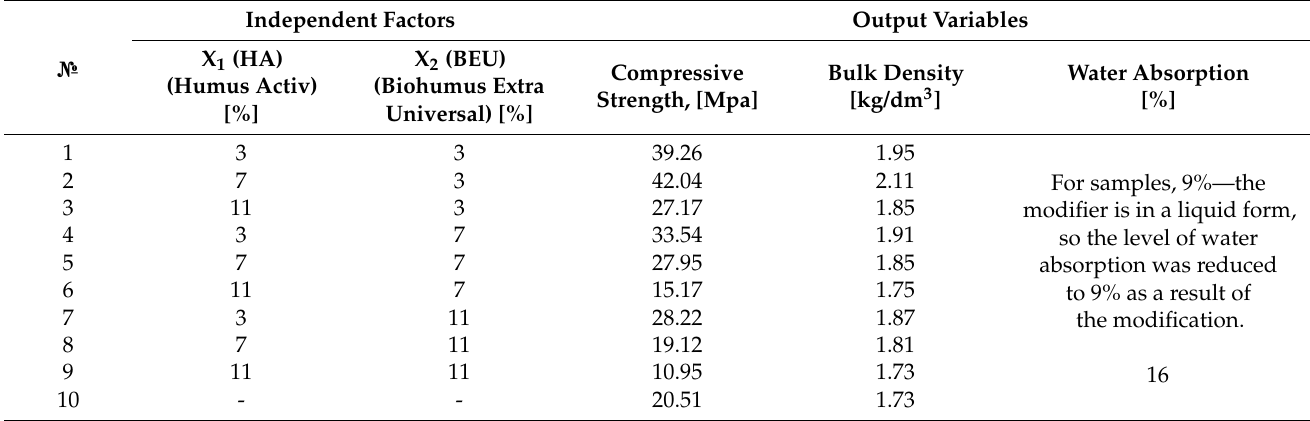
Table 4. Test results for the modification of sand–lime products with organic compounds.